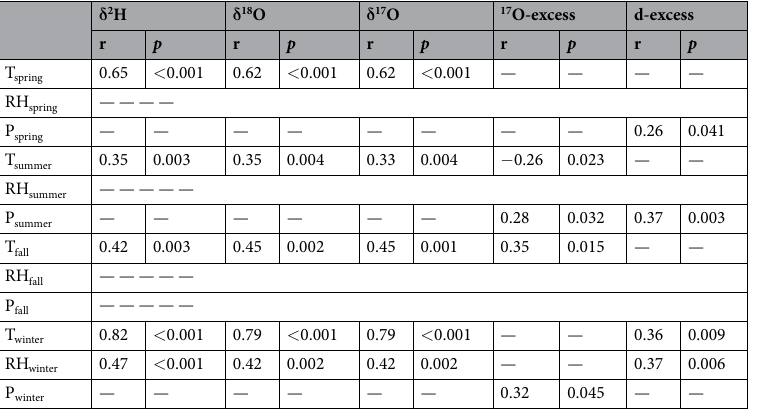
Table 3. The relationships between the daily precipitation isotopes ( δ 2 H/ δ 18 O/ δ 17 O), 17 O-excess, d-excess